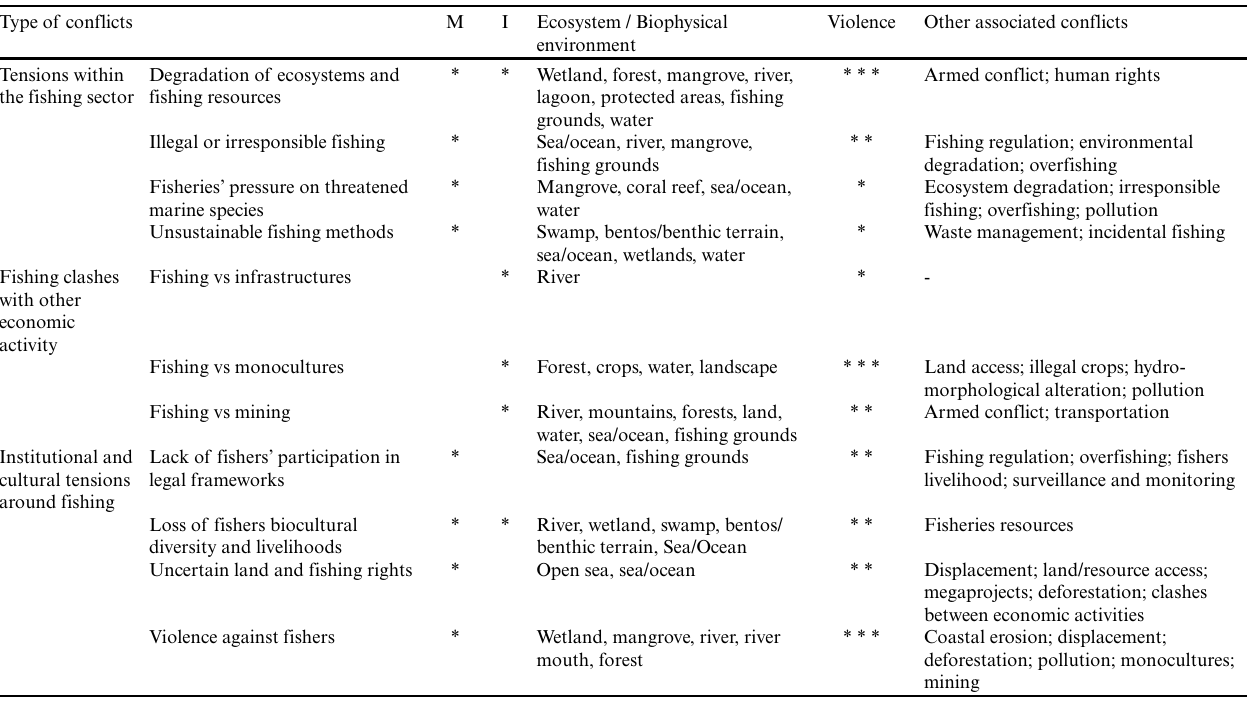
Table 1 . Types of detected fisheries conflicts, affected ecosystems, and related issues. Source: Content of the films and questionnaires completed by film producers. Note: M (Marine), I (Inland); the dot represents occurrence. Violence is rated according the perception of the film producers on the extent to which their own piece represents violence (*** High; ** Medium; * Low). Type of conflicts M I Ecosystem / Biophysical environment